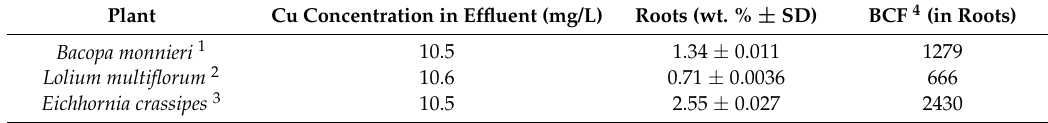
Table 1. The copper concentration in roots and bioconcentration factor (BCF) calculation.